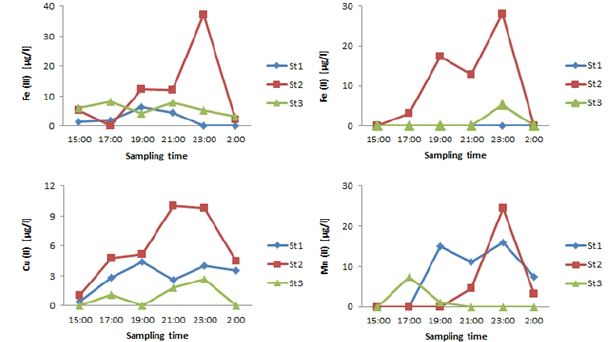
Figure 6. Trends in total trace metal cloud water concentrations during selected full cloud events: FCE 1.1: 14–15 September 2010, FCE 11.3: 2 October 2010, FCE 13.3: 6–7 October 2010, and FCE 22.1: 19–20 October 2010.